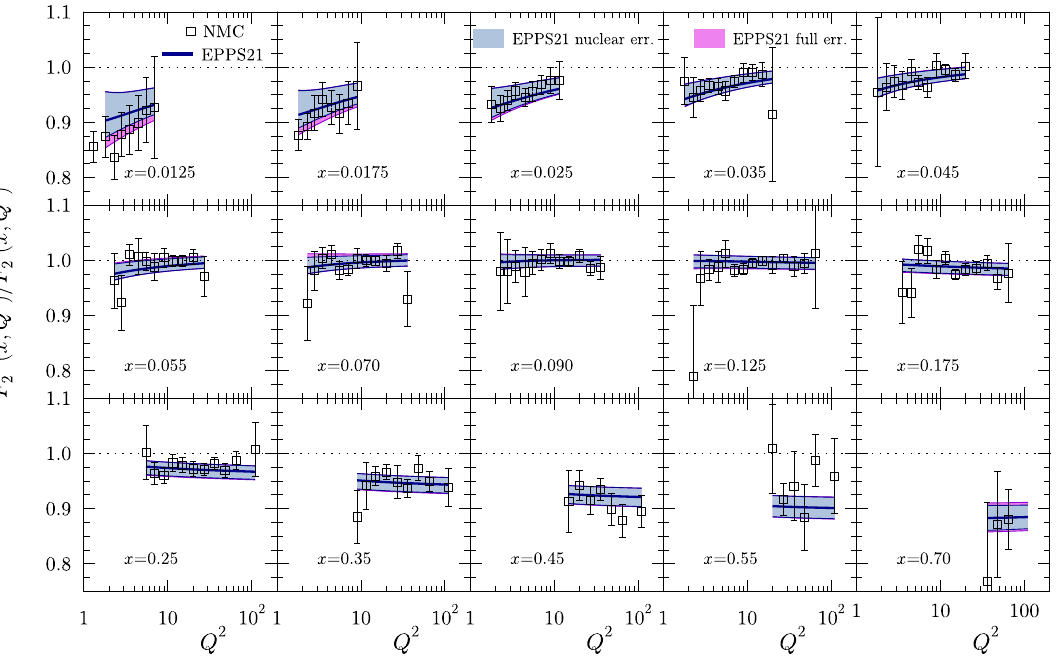
/ F C Fig. 20 The structure–function ratios F Sn as a function of Q 2 for several fixed values of x . The data is from the NMC experiment [47]. The 2 2 solid blue points show our central results, inner blue bands the nuclear uncertainties, and the purple bands the total